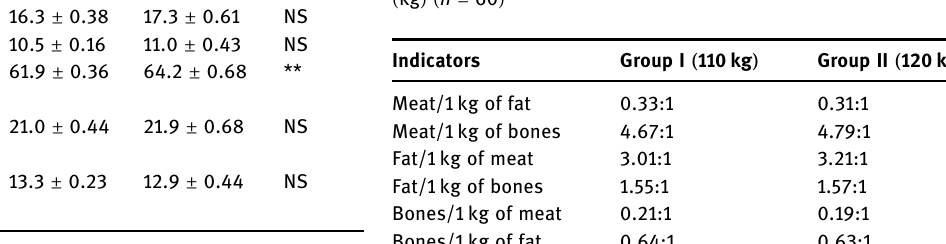
Table 6: The ratio of morphological components of pig carcasses